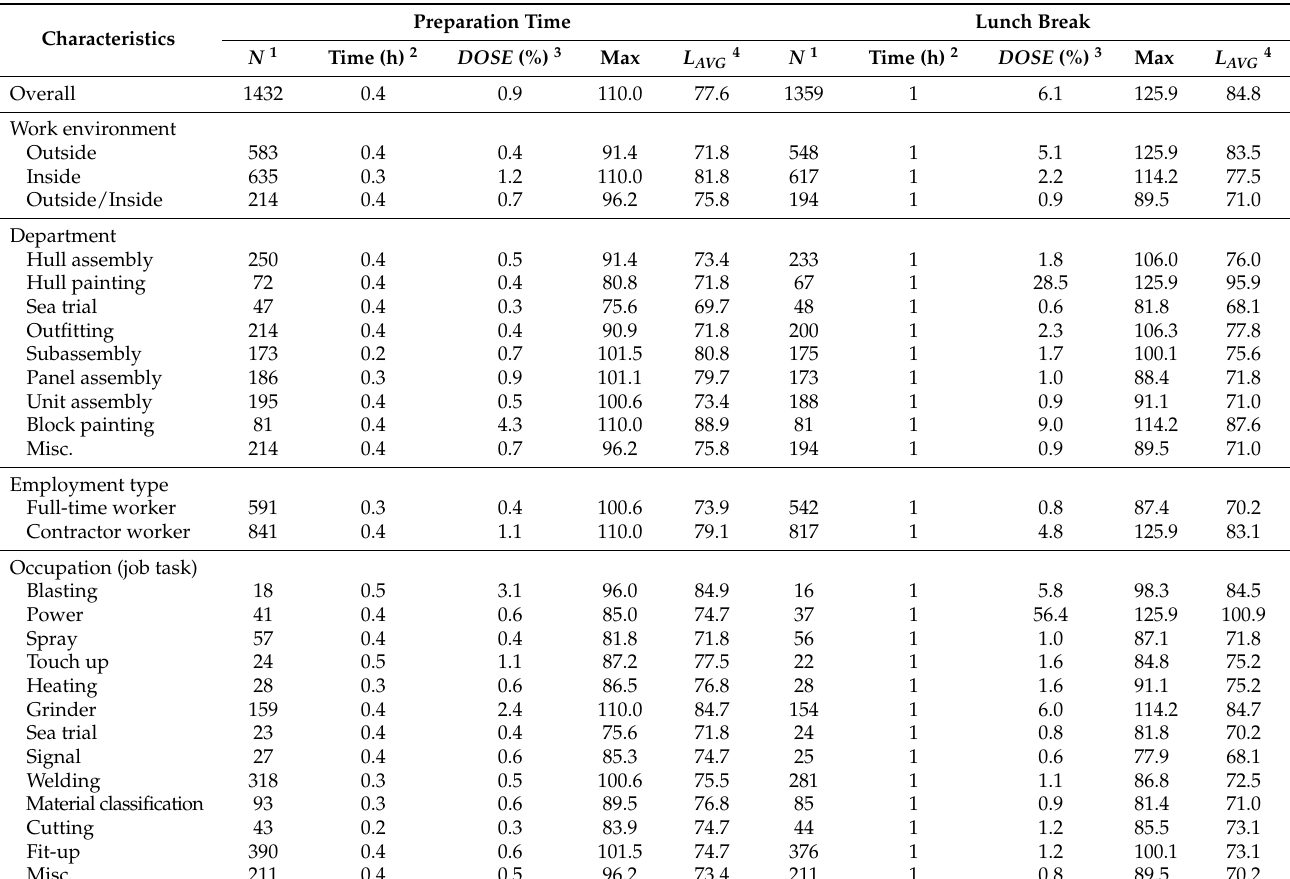
Table 3. The measured results of occupational noise exposure during the break periods in the shipbuilding workplaces.